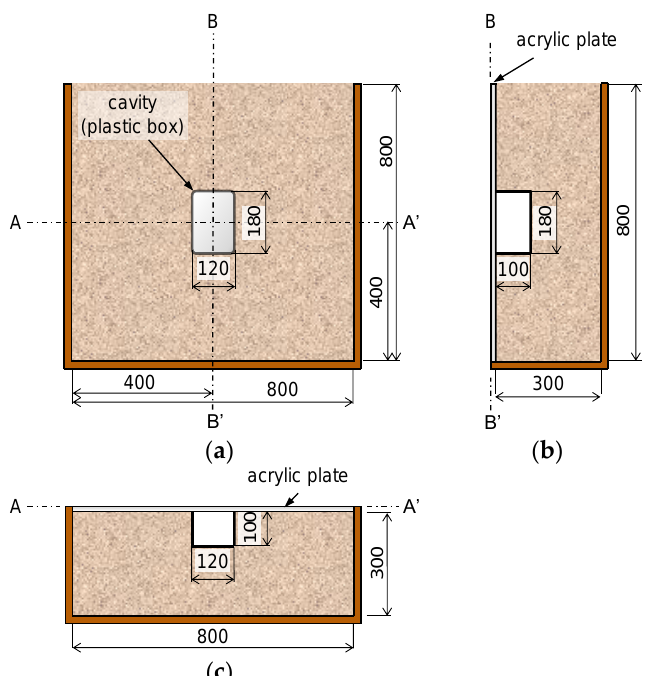
Figure 2. Schematic drawings of chamber: ( a ) front view; ( b ) side view; and ( c ) bottom view. Units are given in mm.